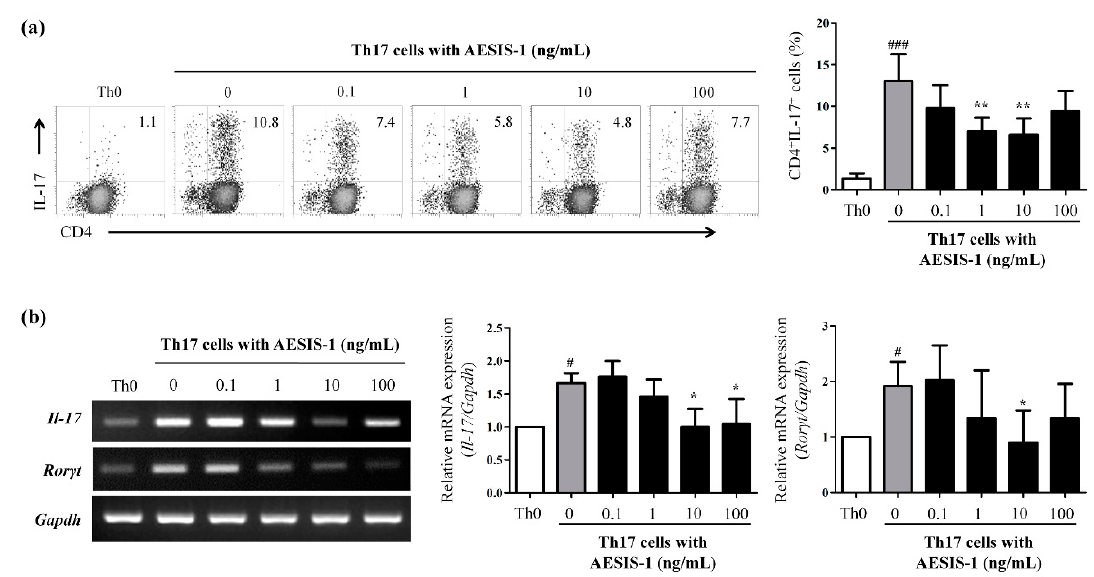
Figure 5. AESIS-1 suppressed the frequency and mRNA expression of Th17 cells in vitro. Naïve CD4 + T cells were isolated and purified from lymph nodes of 6 week old DBA / 1J mice using magnetic beads. The purified naïve CD4 + T cells were cultured with Th17 polarizing cytokines TGF- β (5 ng / mL) and IL-6 (20 ng / mL) in the presence of plate-bound anti-CD3 Ab (1 µ g / mL) and soluble anti-CD28 Ab (1 µ g / mL) for 3 days. The cells were then incubated without or with AESIS-1 (0.1, 1, 10, 100 ng / mL) for 24 h. ( a ) The proportion of CD4 + IL-17 + Th17 cells was analyzed by flow cytometry as described in Materials and Methods. Results are shown representative of five independent experiments, and the graph representatively show the percentage of CD4 + IL-17 + Th17 cells. All data were shown in Figure S3; ( b ) The mRNA expression of Il-17A and ROR γ t were analyzed by RT-PCR. Results are shown representative of three independent experiments. ANOVA with Tukey’s post hoc tests was used for statistical analysis. # p ≤ 0.05 and ### p ≤ 0.001, compared with Th0 cells. * p ≤ 0.05 and ** p ≤ 0.01, compared with Th17 cells without AESIS-1.